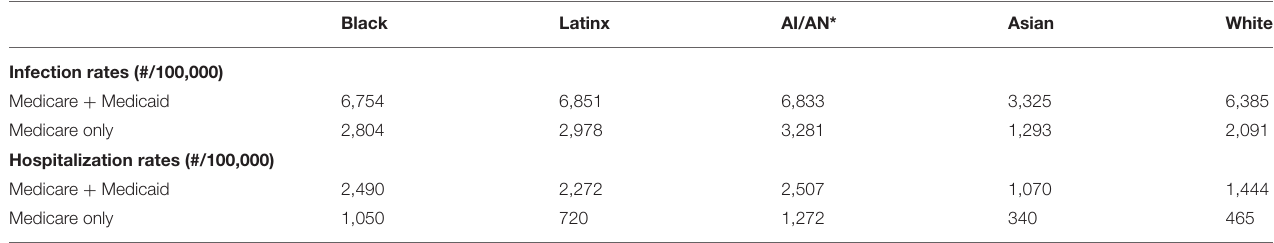
TABLE 6 | COVID-19 infection and hospitalization rates/100,000 Medicare beneficiaries, by race, ethnicity and Medicaid eligibility, US, January 1-November 21, 2020.